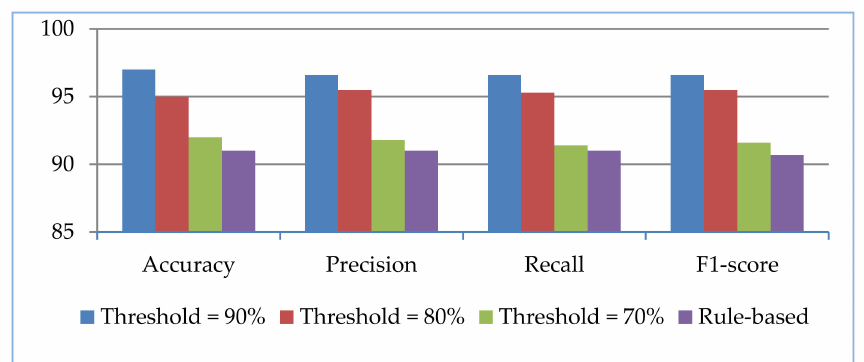
Figure 6. LSTM Classification Results.